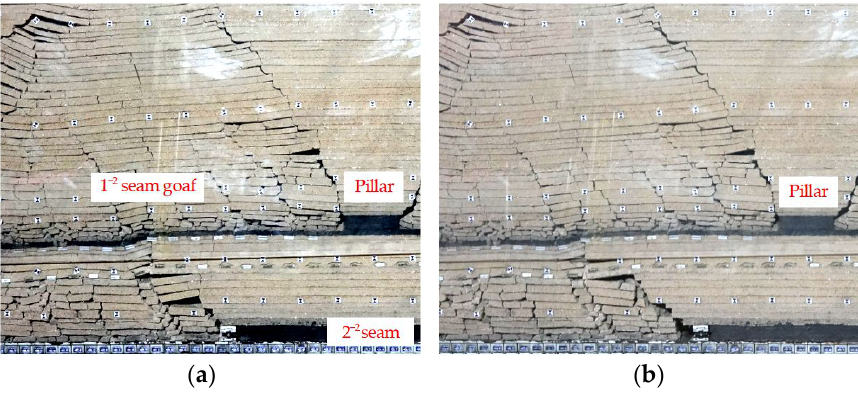
Figure 9. Law of period weighting under the goaf: ( a ) FPW4. ( b ) FPW5.